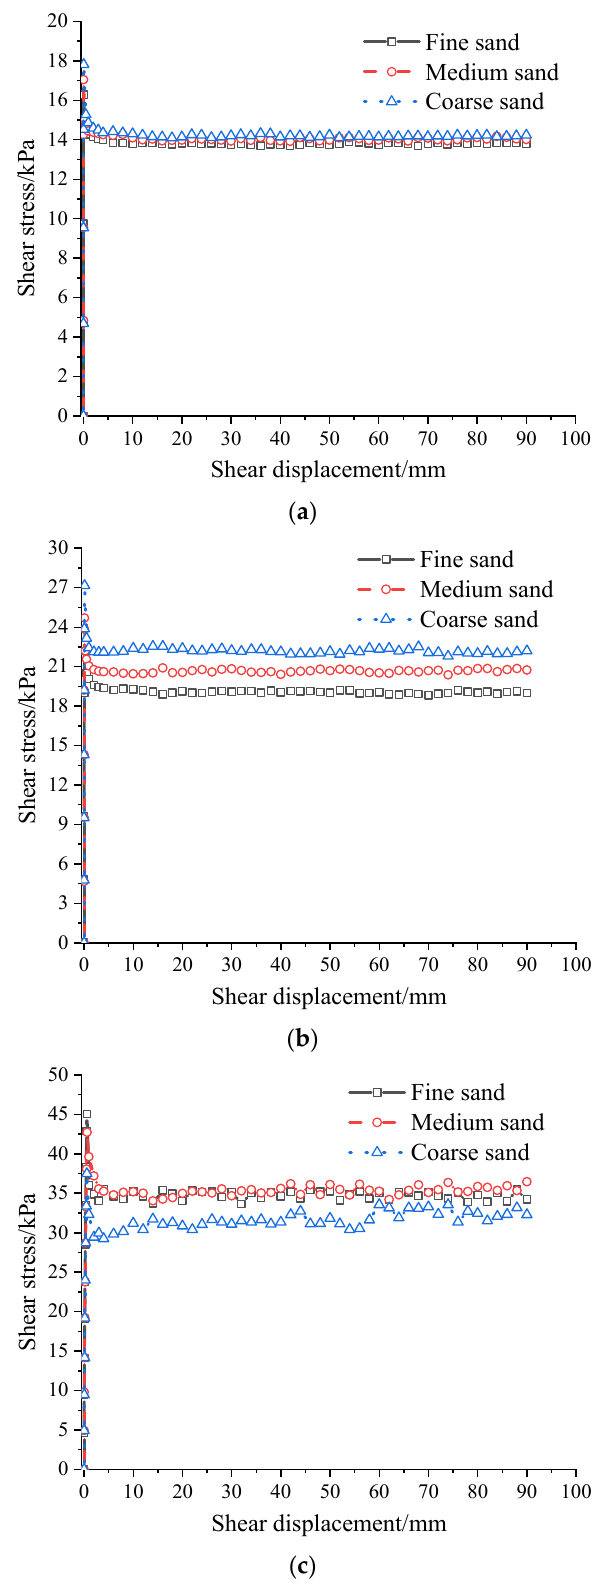
Figure 6. Shear stress ‒ shear displacement curves of sand for different particle sizes. ( a ) #45 steel pile (Surface hardness HV = 660). ( b ) Aluminum alloy pile (Surface hardness HV = 350). ( c ) PMMA pile (Surface hardness HV = 95).